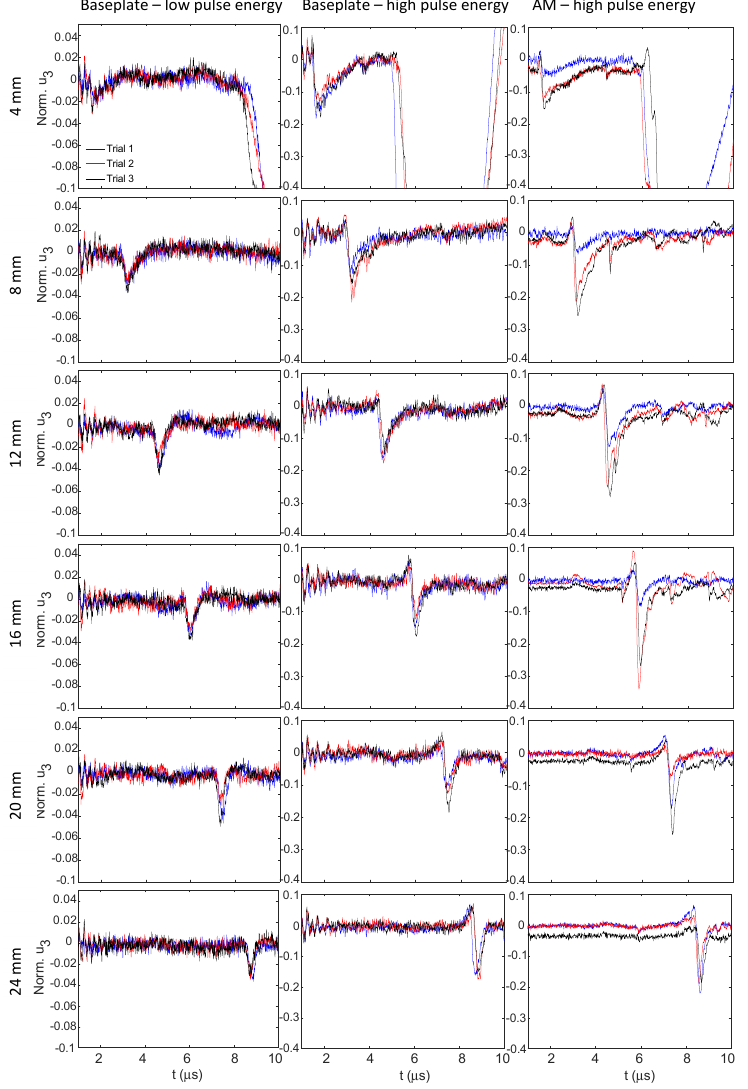
Figure 6. Sample u 3 displacement waveforms for Ti-6Al-4V received by laser interferometer after propagation distances of 4–24 mm for baseplate and AM deposition.